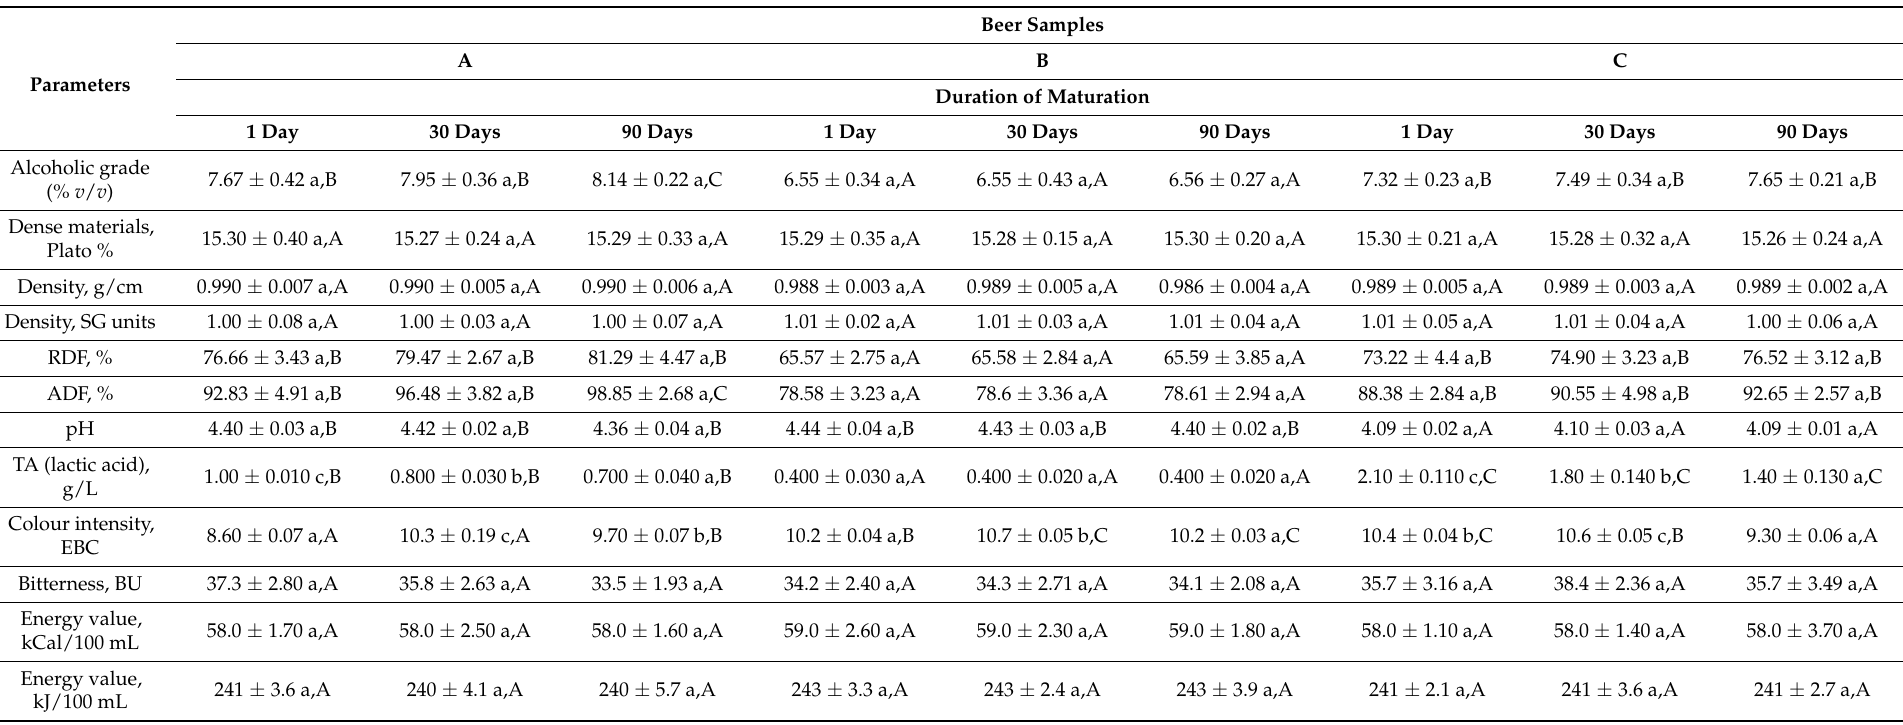
Table 1. The dry matter content, density, pH, real degree of fermentation (RDF), apparent degree of fermentation (ADF), energy value, ethanol and methanol concentrations, colour intensity, and bitterness of the beer samples (A—beer fermented with Saccharomyces cerevisiae var. diastaticus ; B—beer fermented with Saccharomyces cerevisiae var. bayanus ; C—beer fermented with Brettanomyces claussenii